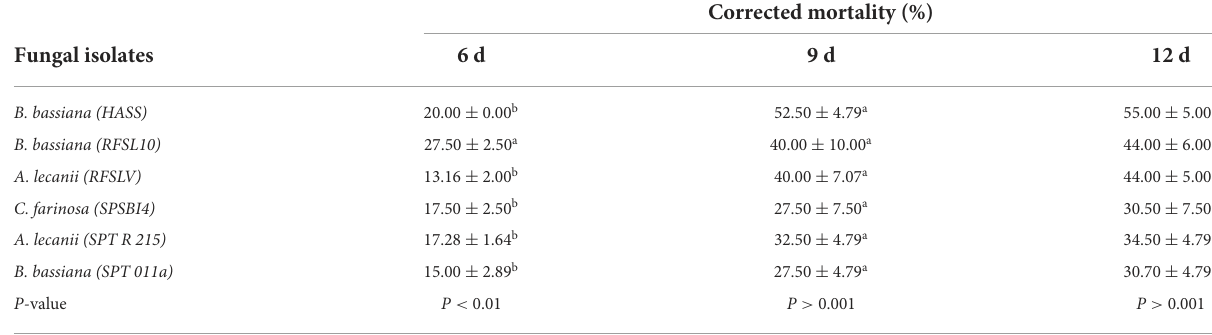
Corrected mortality